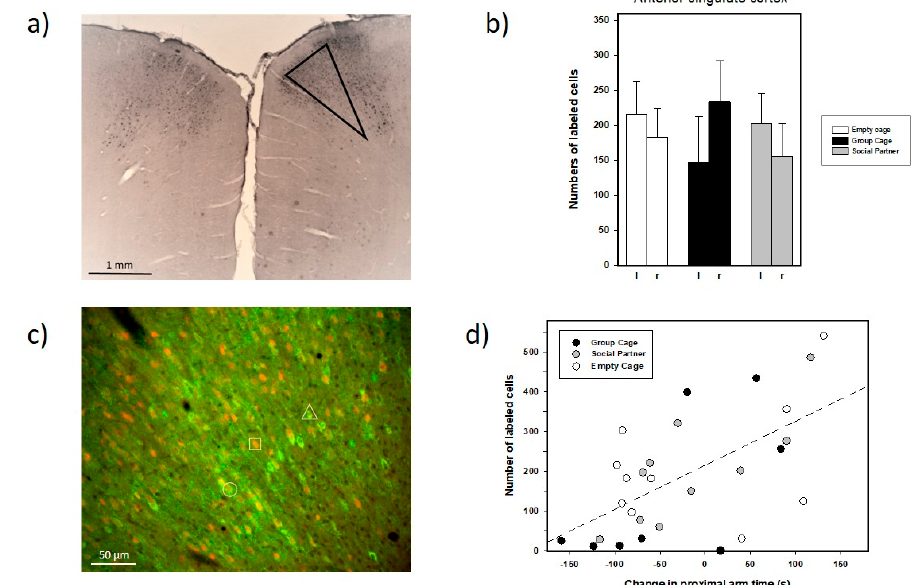
Figure 12. ( a ): Histological example (approximately plate 16, i.e., Bregma 0.84 mm, of the atlas of Paxinos and Watson [42] showing dense c ‐ fos labeling in the ACC and the adjacent M2. ( b ) Numbers of c ‐ fos ‐ positive cells in the ACC of the left (l) and right hemisphere (r) in animals, which had access to a conspecific (Social Partner, gray bars), no social contact (Empty Cage, white bars) or their cage mates (Group Cage, black bars) immediately after playback in the initial test. Data are presented as means + SEM. ( c ) c ‐ Fos and GAD immunolabeled cells in the ACC. Microscopic image depicting double ‐ immunofluorescent labeling taken within the triangulated area shown in a. c ‐ Fos immuno ‐ reactive neurons are labeled in red (Cy3) and GAD neurons in green (Alexa488): Note single labeled neurons positive for c ‐ fos (indicated by square) or for GAD (indicated by triangle) and cells co ‐ positive for c ‐ fos and GAD (indicated by circle) located in the ACC. ( d ) Scatter plot plus regression line depicting the individual relationships between the number of c ‐ fos ‐ positive cells in the ACC and approach, i.e., the change in proximal arm times during playback of 50 ‐ kHz USV in the retest in animals, which had access to a conspecific (Social Partner, gray circles), no social contact (Empty Cage, white circles) or their cage mates (Group Cage, black circles) immediately after playback in the initial test.